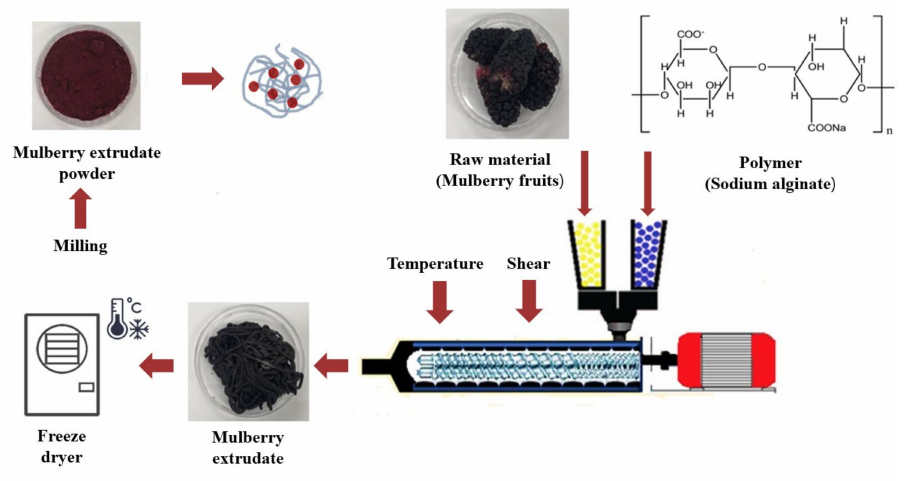
Figure 8. A schematic illustration of mulberry (MUL) production by hot-melt extrusion (HME)